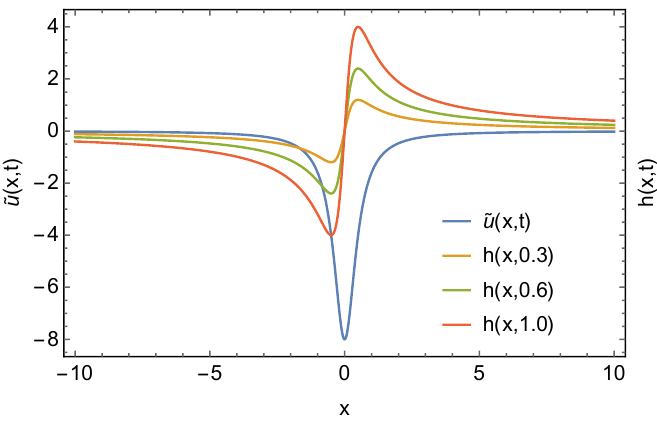
Figure 5: Nonlinear surface wave profiles ˜ u ( x ) , h ( x , t ) for different times t =